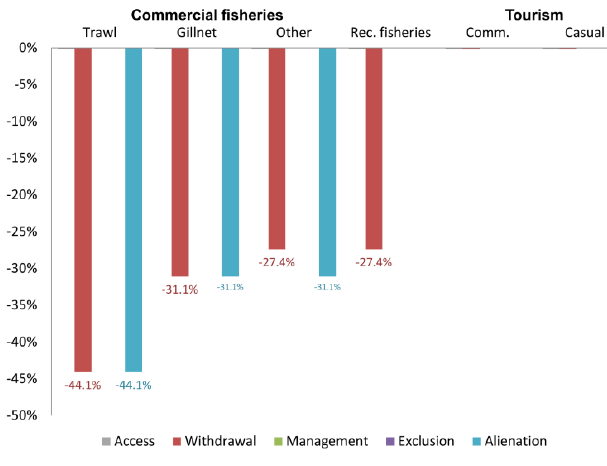
Fig. 5. Changes in property rights (% area) in the Great Barrier Reef Marine Park due to rezoning in 2004 by activity. Changes < 1% are not visible in the figure. Access rights declined by 0.1% for all activities. Withdrawal rights (nonconsumptive) declined by 0.1% for commercial and casual tourism. Management and exclusion rights did not